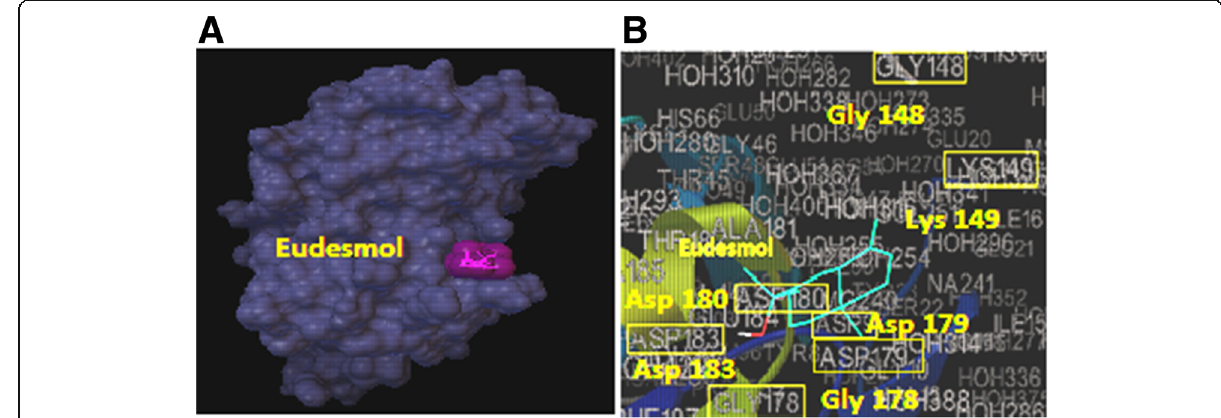
Fig. 9 a , b Docking pose of model TPP with phytochemical eudesmol